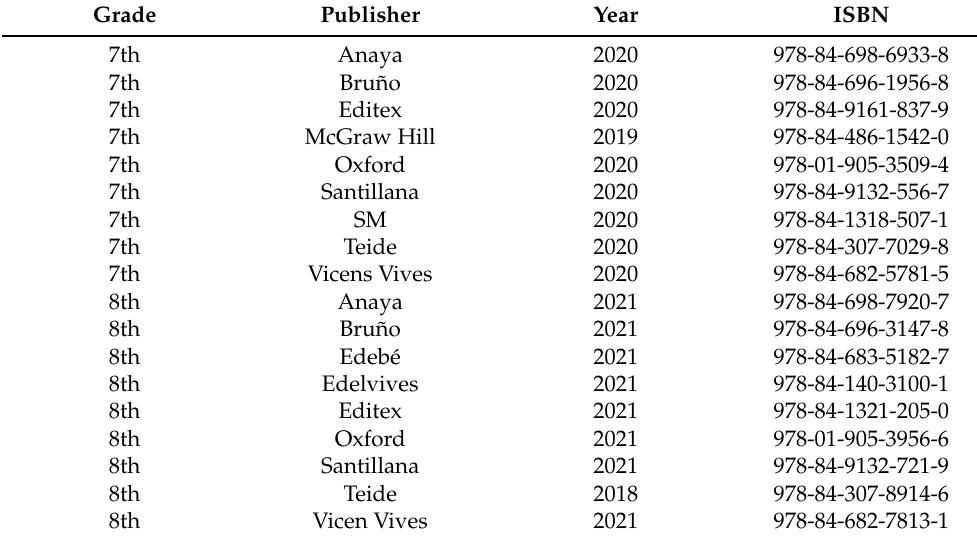
Table 1. Textbooks analysed; grade, publisher, year of publication, and ISBN.